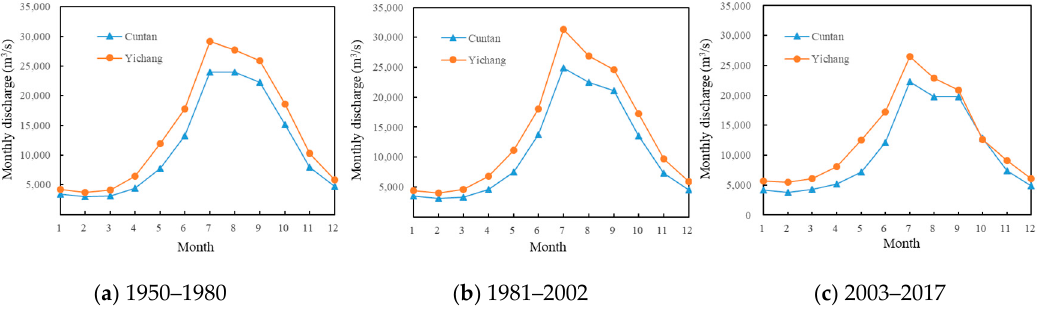
Figure 2. Impact of reservoir regulation on mean monthly discharge.